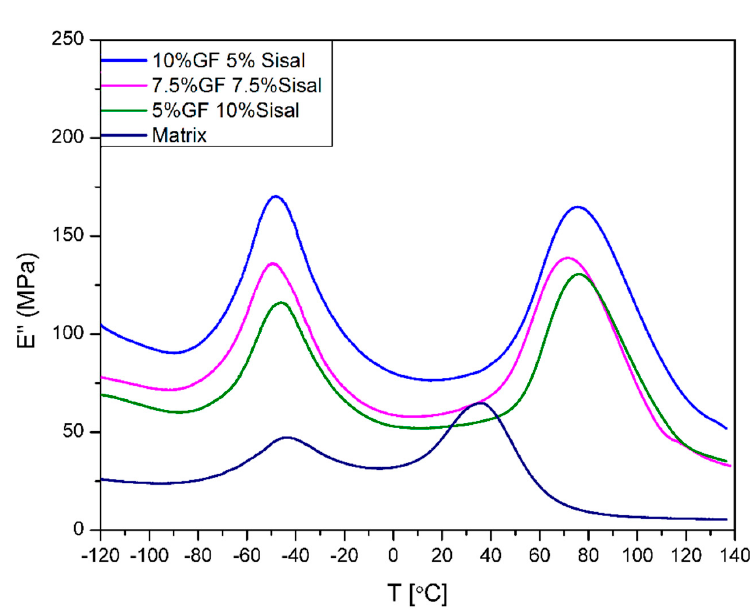
Figure 11. Loss modulus values of obtained hybrids.